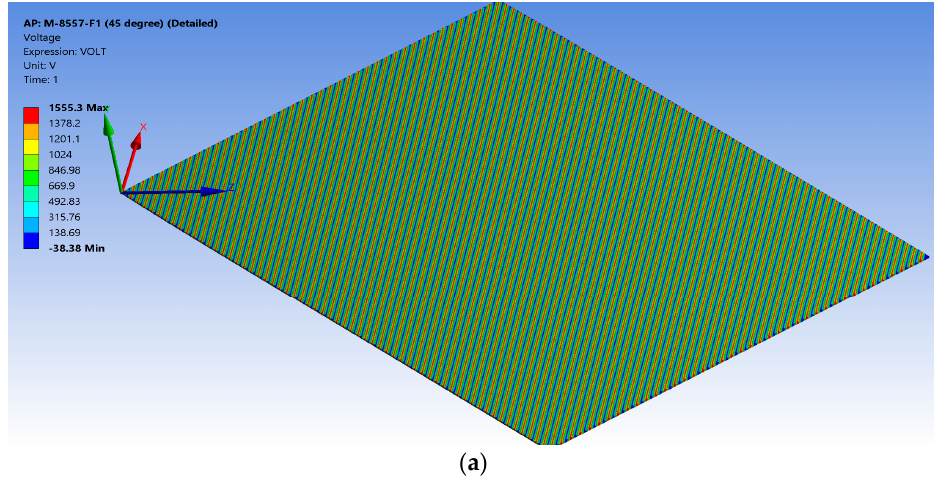
1 GB, a result file size of about 63 MB, and an elapsed simulation time of about 209 s.